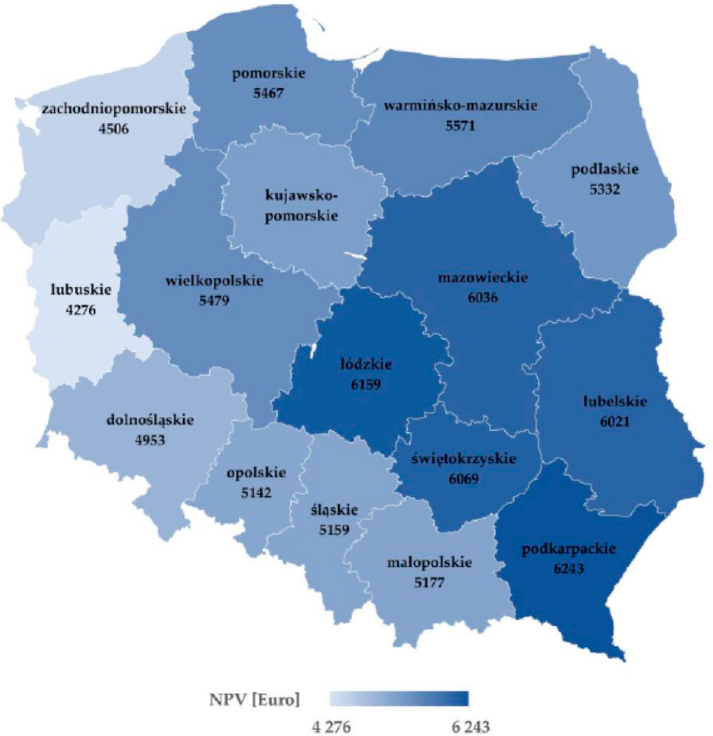
Figure 4. The mean NPV value on a macroeconomic level in particular voivodships [Euro]. From the perspective of economic efficiency, the most beneficial roof orientation is a southern orientation, as well as a south-eastern and south-western one. The nationwide mean for the economic efficiency in the case of the southern orientation is 15% higher than the economic efficiency of the western orientation, and it is 12% higher for an eastern orientation. However, when comparing the mean efficiency for the southern orientation with the values obtained for south-eastern and south-western values, it can be stated that it is 2% higher than the south-eastern orientation and 4% higher than the south-western orientation (Figure 5).